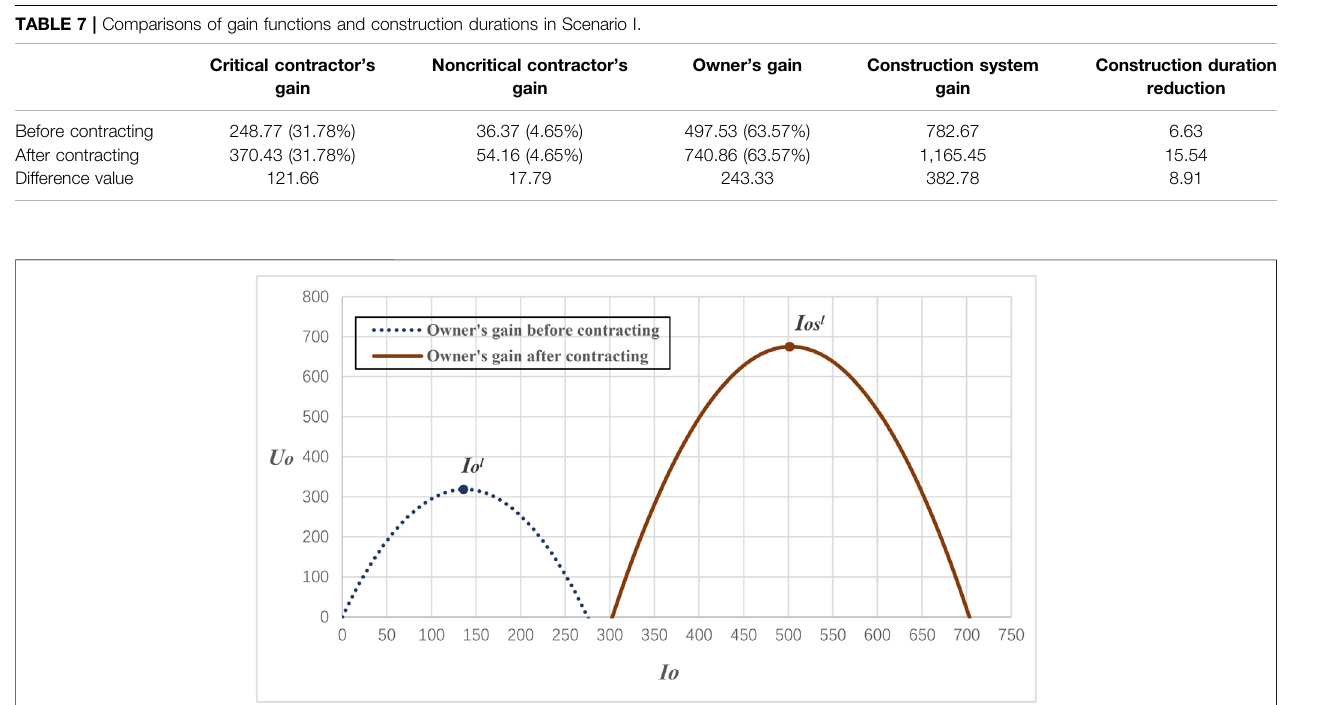
Frontiers in Built Environment |